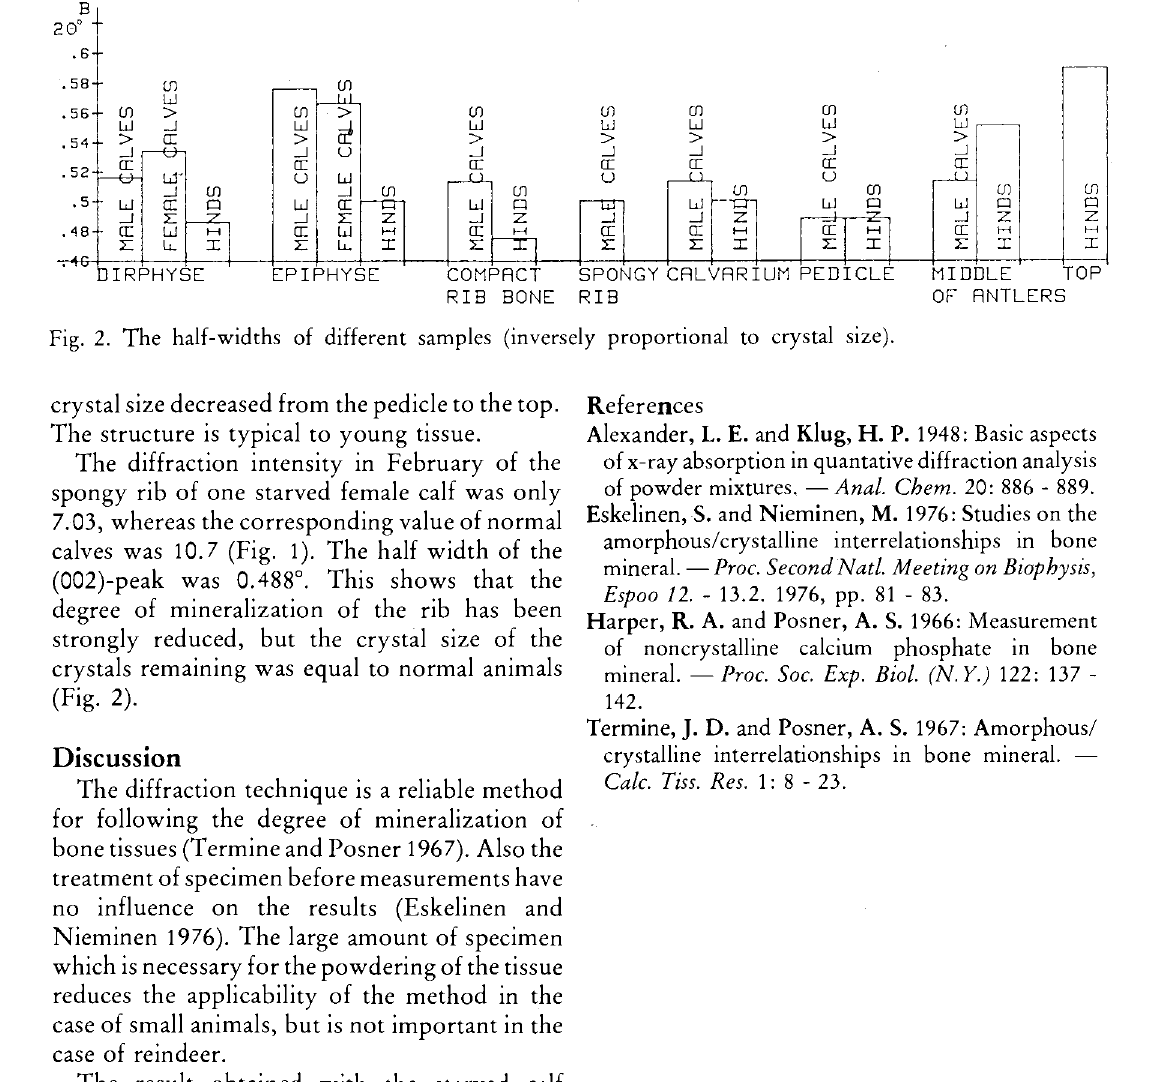
Fig. 2. The half-widths of different samples (inversely proportional to crystal size).